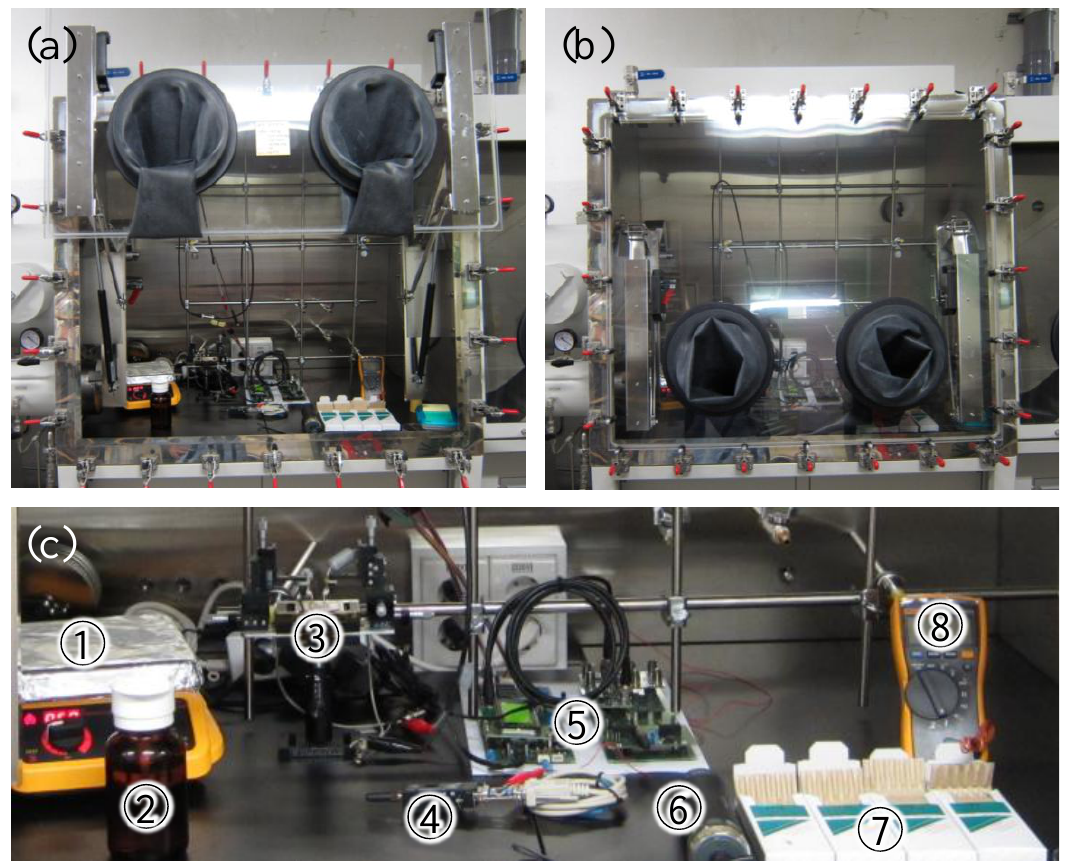
Figure 4. Experimental setup for detection and calibration of concentration of methanol vapor; ( a ) open glove box, ( b ) closed glove box, and ( c ) measurement devices and vapor control devices ( 1 : hot plate, 2 : methanol solution, 3 : CNT sensor, 4 : Bluetooth